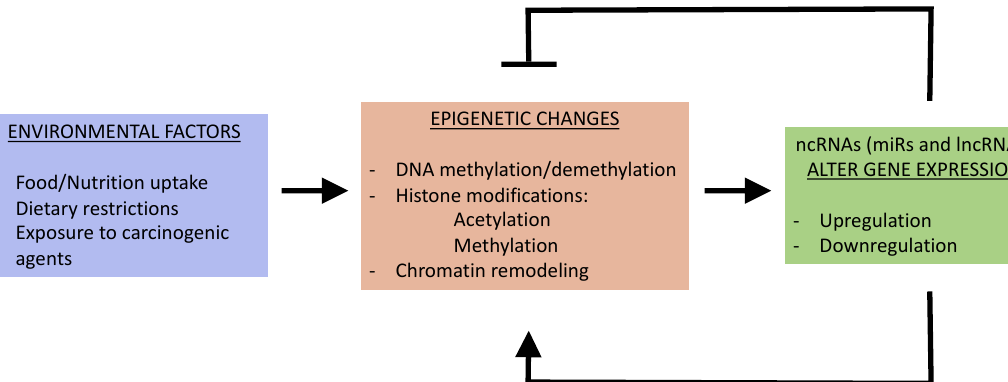
Figure 3. Non-coding RNAs (NcRNAs) in cancer. A decrease in cell cycle arrest and apoptosis, along with an increase in cell proliferation, are hallmarks of cancer cells associated with solid tumors and hematological malignancies. NcRNAs can regulate these cancer hallmarks by the direct targeting of cancer-promoting genes involved in the cell cycle, apoptosis and proliferation or by targeting epigenetic factors that modulate the expression of such genes. Additionally, lncRNAs can regulate the expression of cancer-promoting genes by functioning as sca ff olds to recruit epigenetic factors or by acting as